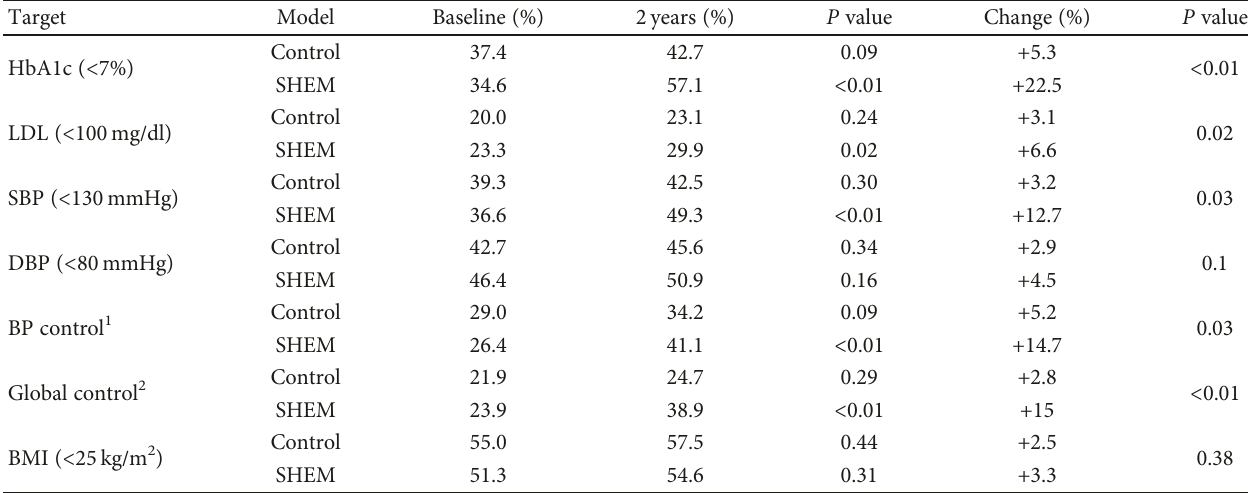
Table 3: Percentage of subjects on-target for cardiovascular risk